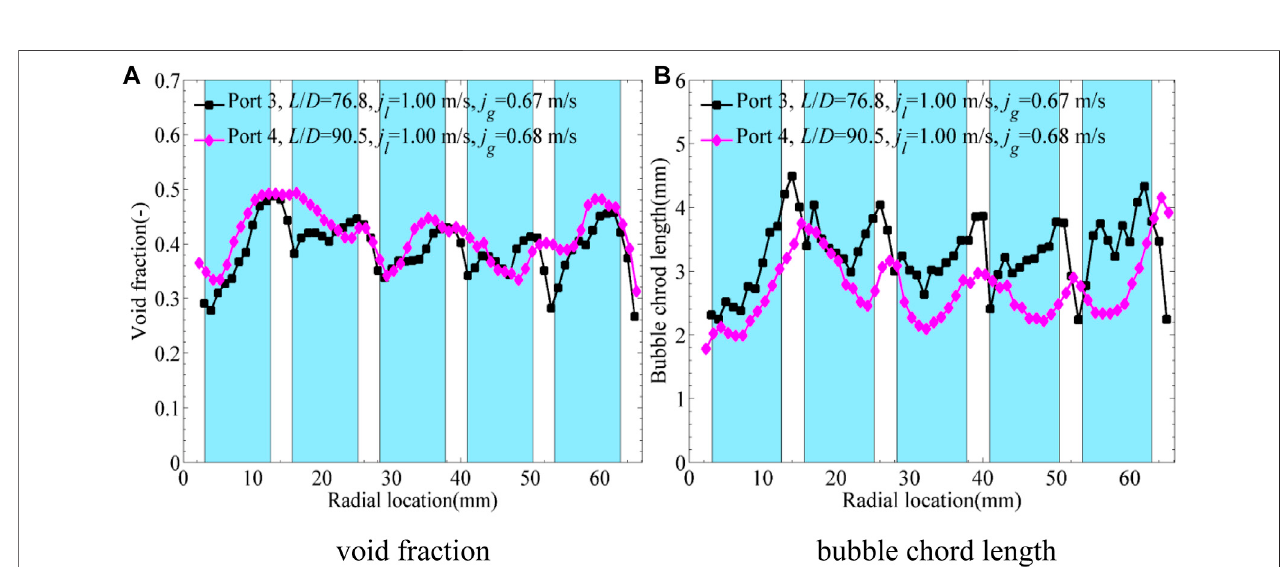
FIGURE 12 | In fl uence of MVSG on core-peak phase distribution. (A) Void fraction. (B) Bubble chord length.